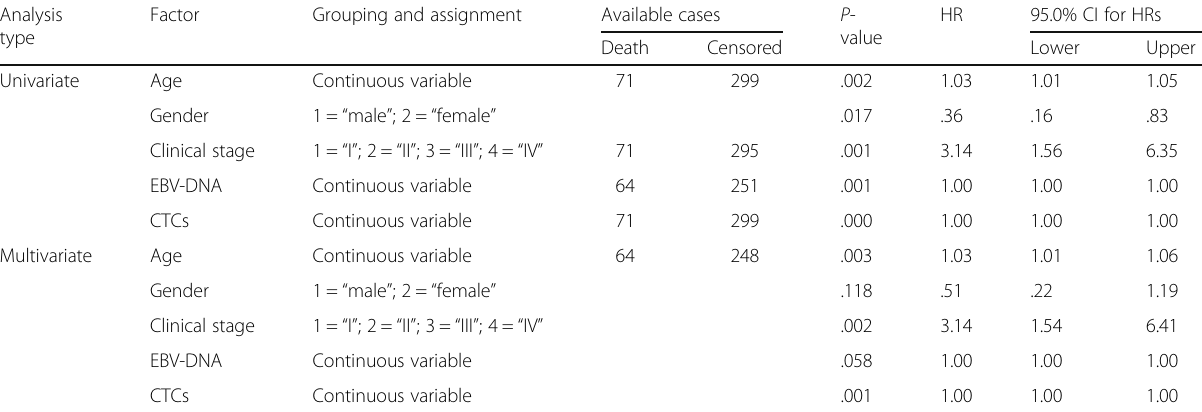
Table 1 Variables assignment and analysis results of Cox ’ s regression models for NPC Analysis type